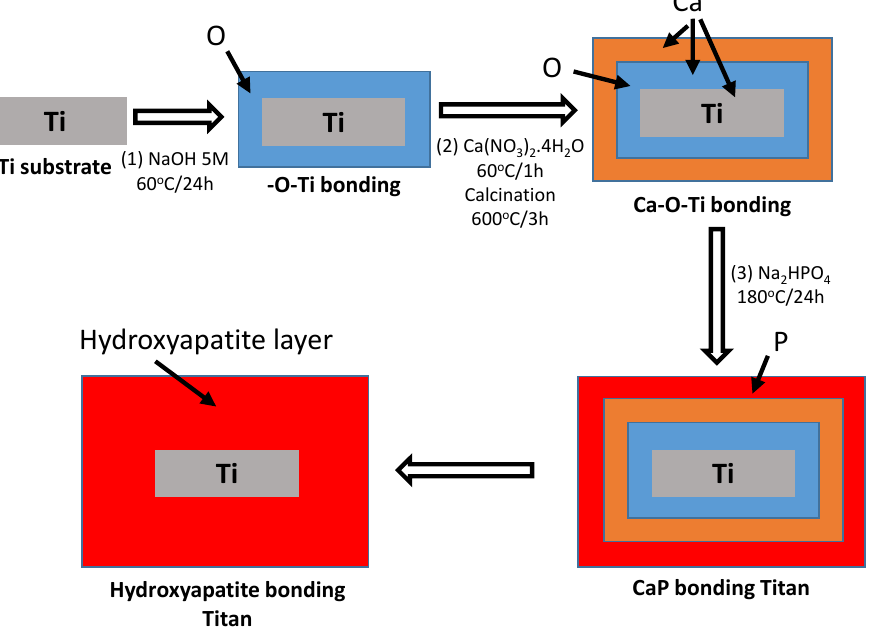
Figure 7. Summary layout of HA coating on the surface of Ti substrate by precipitation and hy- drothermal